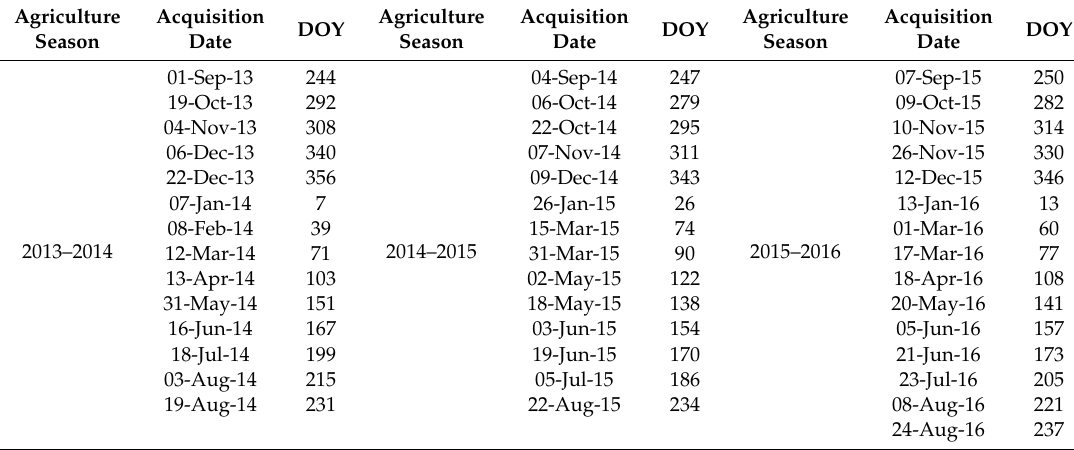
Table 2. List of available Landsat-8